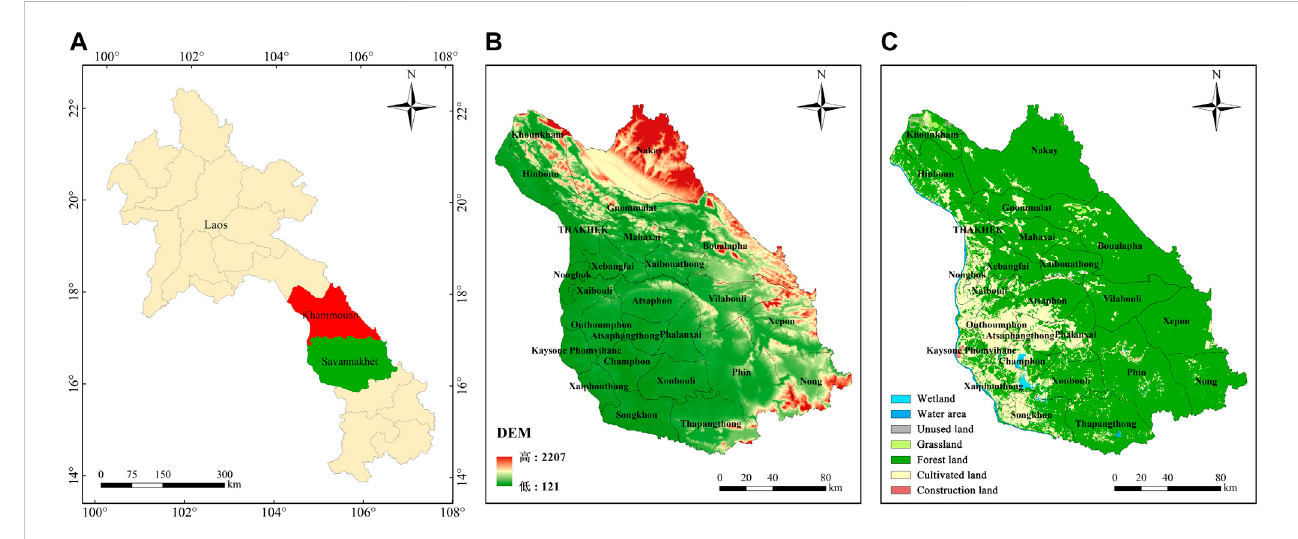
FIGURE 1 Study area: (A) Location; (B) DEM; (C) land use in 2020.